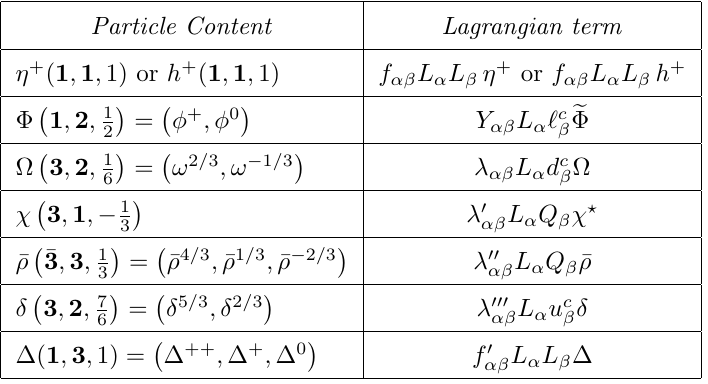
Table 1 . Summary of new particles, their SU(3) c the non-Abelian charges in boldface), (cid:12)eld components and electric charges (in superscript), and corresponding Lagrangian terms responsible for NSI in various type-I radiative neutrino mass models discussed in sections 4, 5 and 7. Here e (cid:8) = i(cid:28) 2 (cid:8) ? , with (cid:28) 2 being the second Pauli matrix. For